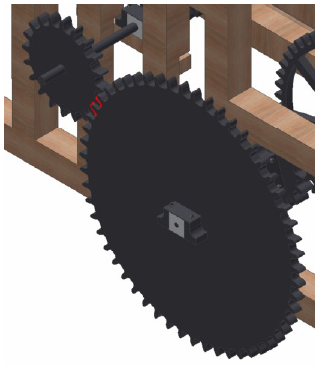
Figure 8. Manual contact defined between gears.